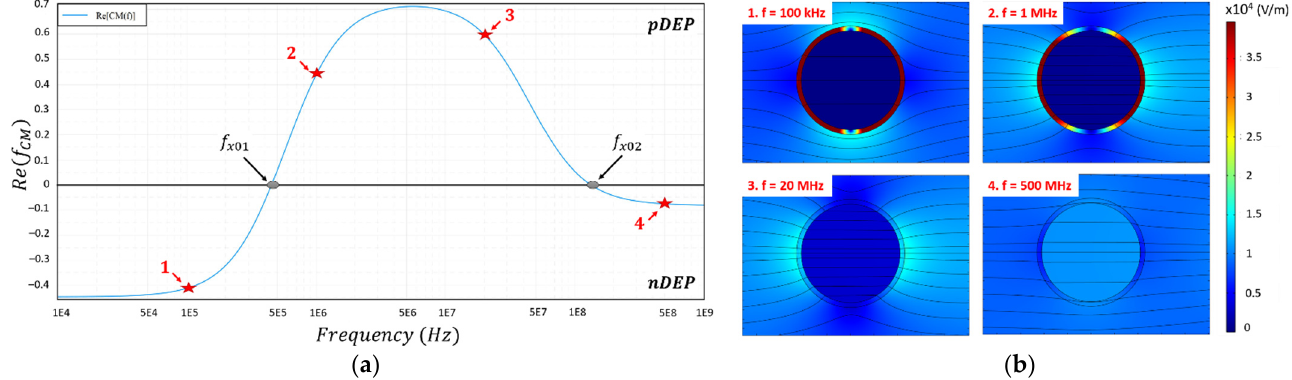
Figure 3. Numerical simulation of a cell dielectric behavior in function of the frequency with the parameters from Table 1. The design used for the biological cell is the single-shell model. ( a ) Numerical simulation of the real part of the Clausius– Mossotti factor. The red stars correspond to the chosen frequencies for the COMSOL simulation; ( b ) COMSOL simulation of the single-shell model for different frequencies (100 kHz; 1 MHz; 20 MHz; 500 MHz) which correspond to the curve of the CM factor. The color scale corresponds to the electric field intensity (V/m) and the black lines correspond to the electric streamlines. Table 1. Values of the different dielectric and cellular parameters used in the COMSOL Multiphys- ics simulation.